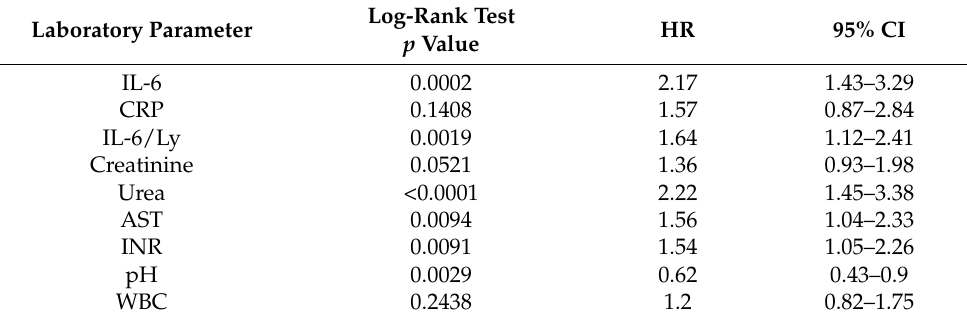
Table 4. Survival data analysis for critical COVID-19